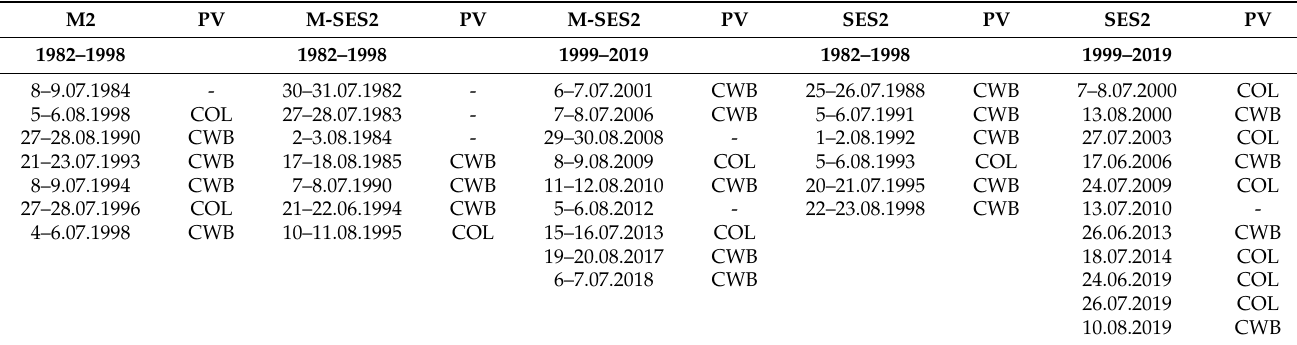
Table 1. The 2-day EPE and the PV